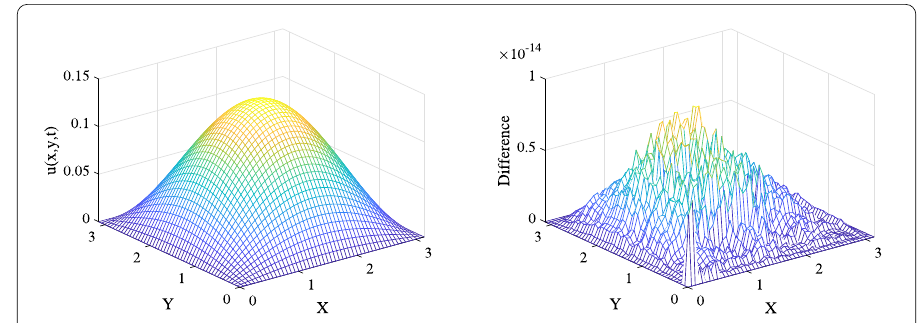
Figure 10 The figures of solutions of R-ADI-CFDS4(left) and difference(right) between R-ADI-CFDS4 and ADI-CFDS4 at t = 2, with h x = h y = 0.02 π and τ = 0.02 for SP 4